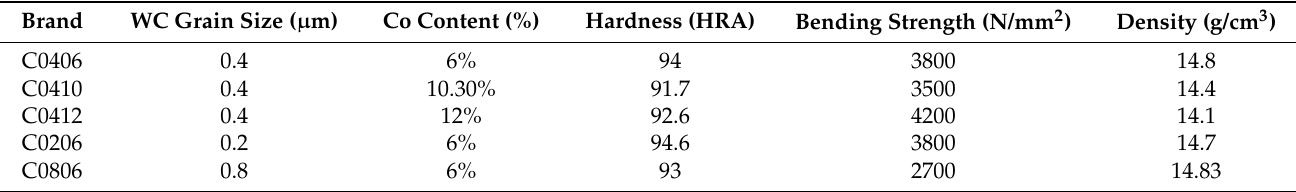
Table 6. Properties and compositions of the cemented carbide samples.